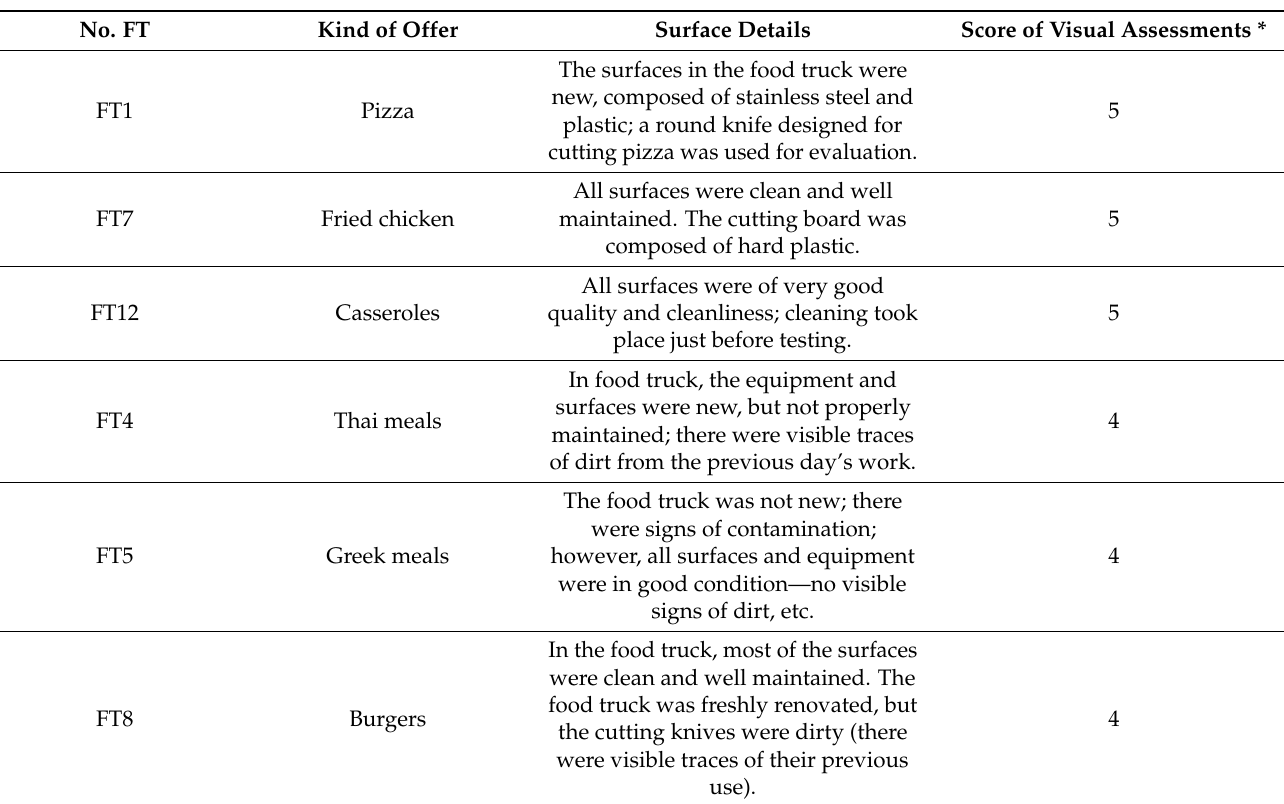
Table 3. The characteristics of the research